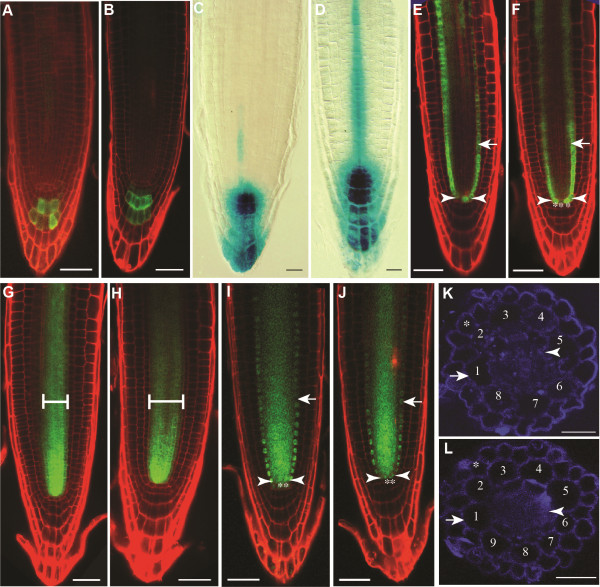
Loss of SPT function alters auxin accumulation but does not disrupt root patterning. (A, B) Confocal micrographs of 5 DAG roots stained with propidium iodide expressing PIN4p::PIN4-GFP. (A) Col-0. (B) spt-11. (C, D) Micrographs of 5 DAG roots expressing DR5::GUS. (C) Col-0. (D) spt-11. (E-J) Confocal micrographs of 5 DAG roots stained with propidium iodide. (E, F) pSCRp::GFP expression. Arrows indicate endodermal cells, asterisks indicate QC cells and arrowheads indicate vascular initials. (E) Col-0. (F) spt-11. (G, H) pSHR::GFP expression. The bracketed region is the stele. (G) Col-0. (H) spt-11. (I-J) pSHR::SHR-GFP expression. Arrows indicate endodermal cells, asterisks indicate QC cells and arrowheads indicate vascular initials. (I) Col-0. (J) spt-11. (K, L) Fluorescent brightener stained free hand cross sections of 7 DAG primary roots. Asterisks indicate the epidermal cell layer. Arrows indicate the cortical cell layer. Arrowheads indicate the endodermal cell layer. Cortical cells are numbered around the diameter. (K) Col-0. (L) spt-11. Scale bars in A-B and D-J indicate 100 μm. Scale bars in B-C and K-L indicate 50 μm.